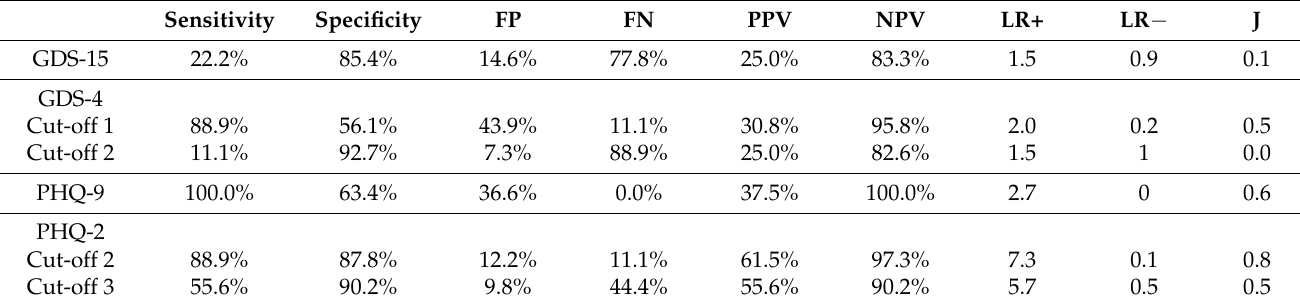
Table 3. Scale properties used to screen for